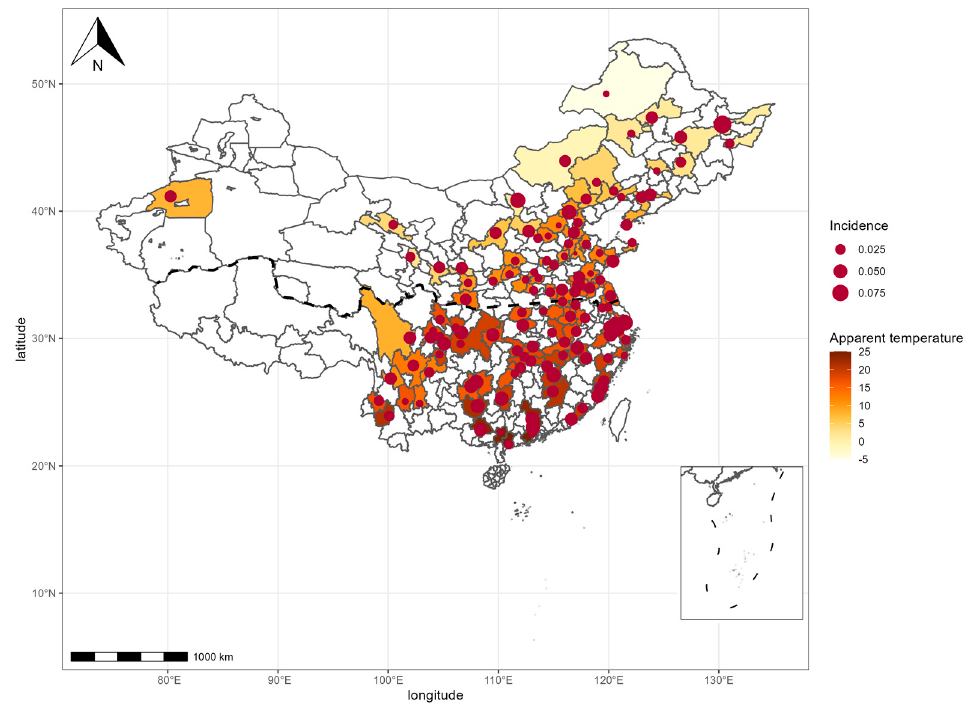
Figure 1. Map of average annual apparent temperature and incidence of depressive symptoms in each city (2011 − 2018). Dashed line refers to Kunlun − Qinling − Huaihe River line, dividing cities into the south and the north. Small islands or areas with missing data are not displayed in that map.